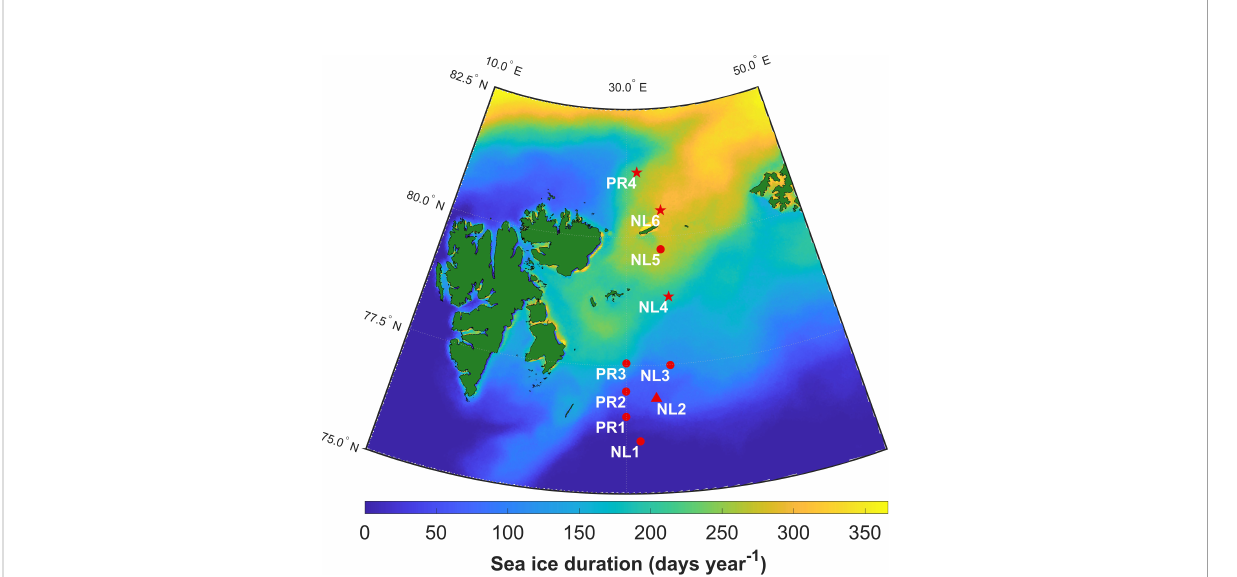
FIGURE 1 Map of sampling stations in the Barents Sea, with duration of sea ice cover from June 2017 to June 2018. Symbols represent the seasons during which stations were sampled: star – summer, triangle – winter, circle – both